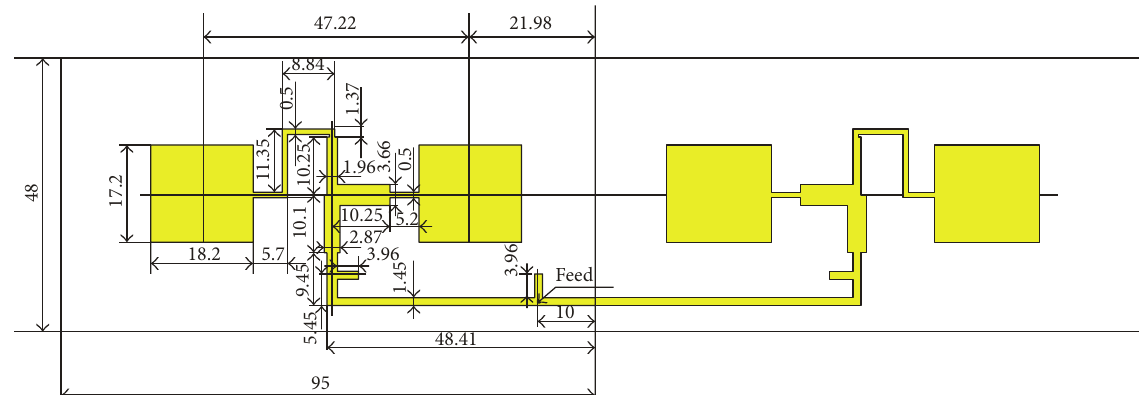
Figure 6: Subarray layout and dimensions